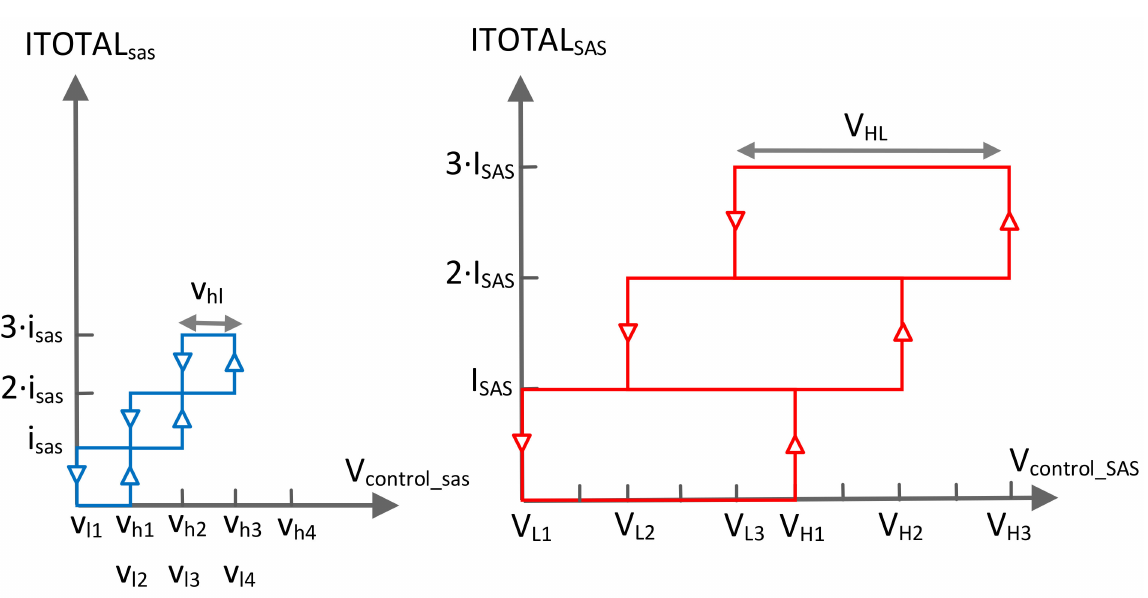
Figure 4. Hysteretic comparator window references: low-power sections (blue) and high-power sections (red). In order to maintain a constant regulator conductance, and that the low-power sec- tions are the only ones that switch to regulate the bus, the high-power sections hysteric comparator window references have to be distributed as shown in Figure 4. The width of these reference windows ( V HL ) is defined by Equation (3).